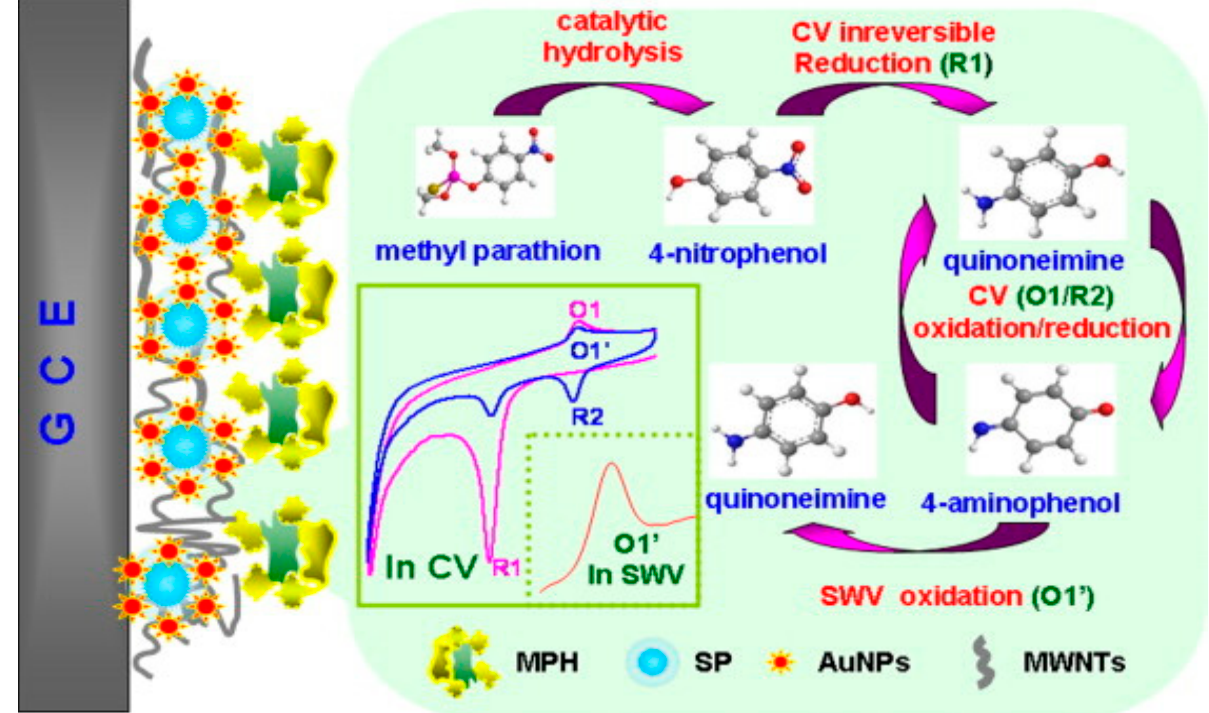
Figure 9. MPH biosensor preparation procedures for methyl parathion determination using modified SP@AuNPs/MWCNTs electrode. Reprinted with permission from [191]. Copyright © 2021 Elsevier B.V. All rights